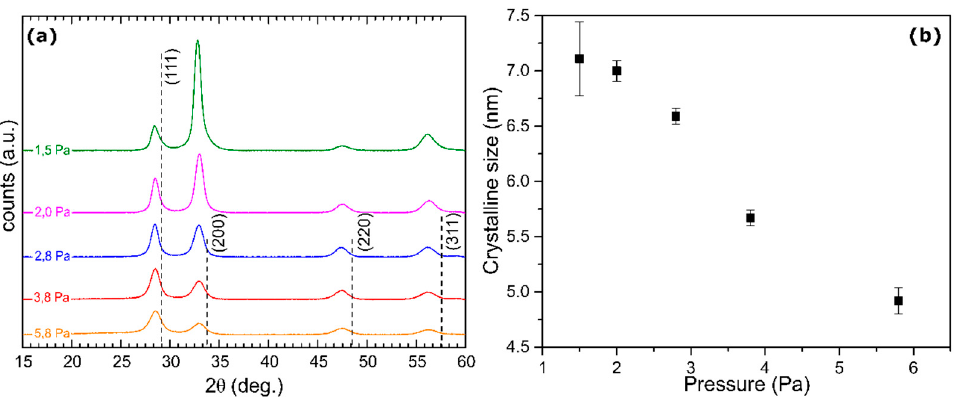
Figure 1. ( a ) Grazing-incidence X-ray diffraction (GIXRD) results for samples deposited at 1.5, 2.0, 2.8, 3.8 and 5.8 Pa. Photochromic films exhibited a change in the relative intensity of the different diffraction peaks as the oxygen incorporation increased due to the increase in deposition pressure. ( b ) The grain size reduced as a result of increased deposition pressure.